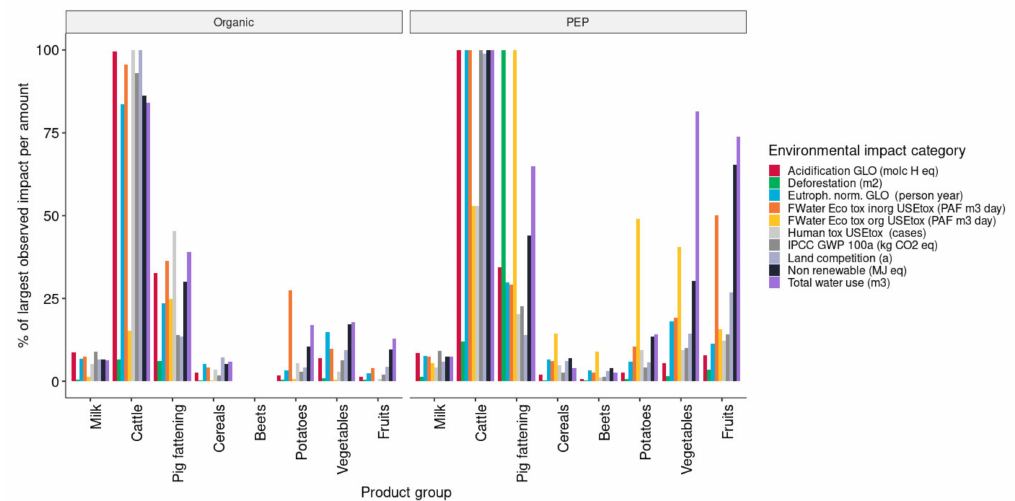
Figure 1. Relative average impact per produced amount (kg dry matter or live weight for each product group. All values are averaged over all observations and normalized by the largest observed averaged value per impact (largest value = 100%). In order to better illustrate the differences between the two farming systems, the impact “Freshwater ecotoxicity USEtox potentially affected fraction of species (PAF) integrated over time and volume (PAF m 3 day)” is split into ecotoxicity of organic and inorganic compounds. (GLO = Global, FWater = Freshwater, eq =